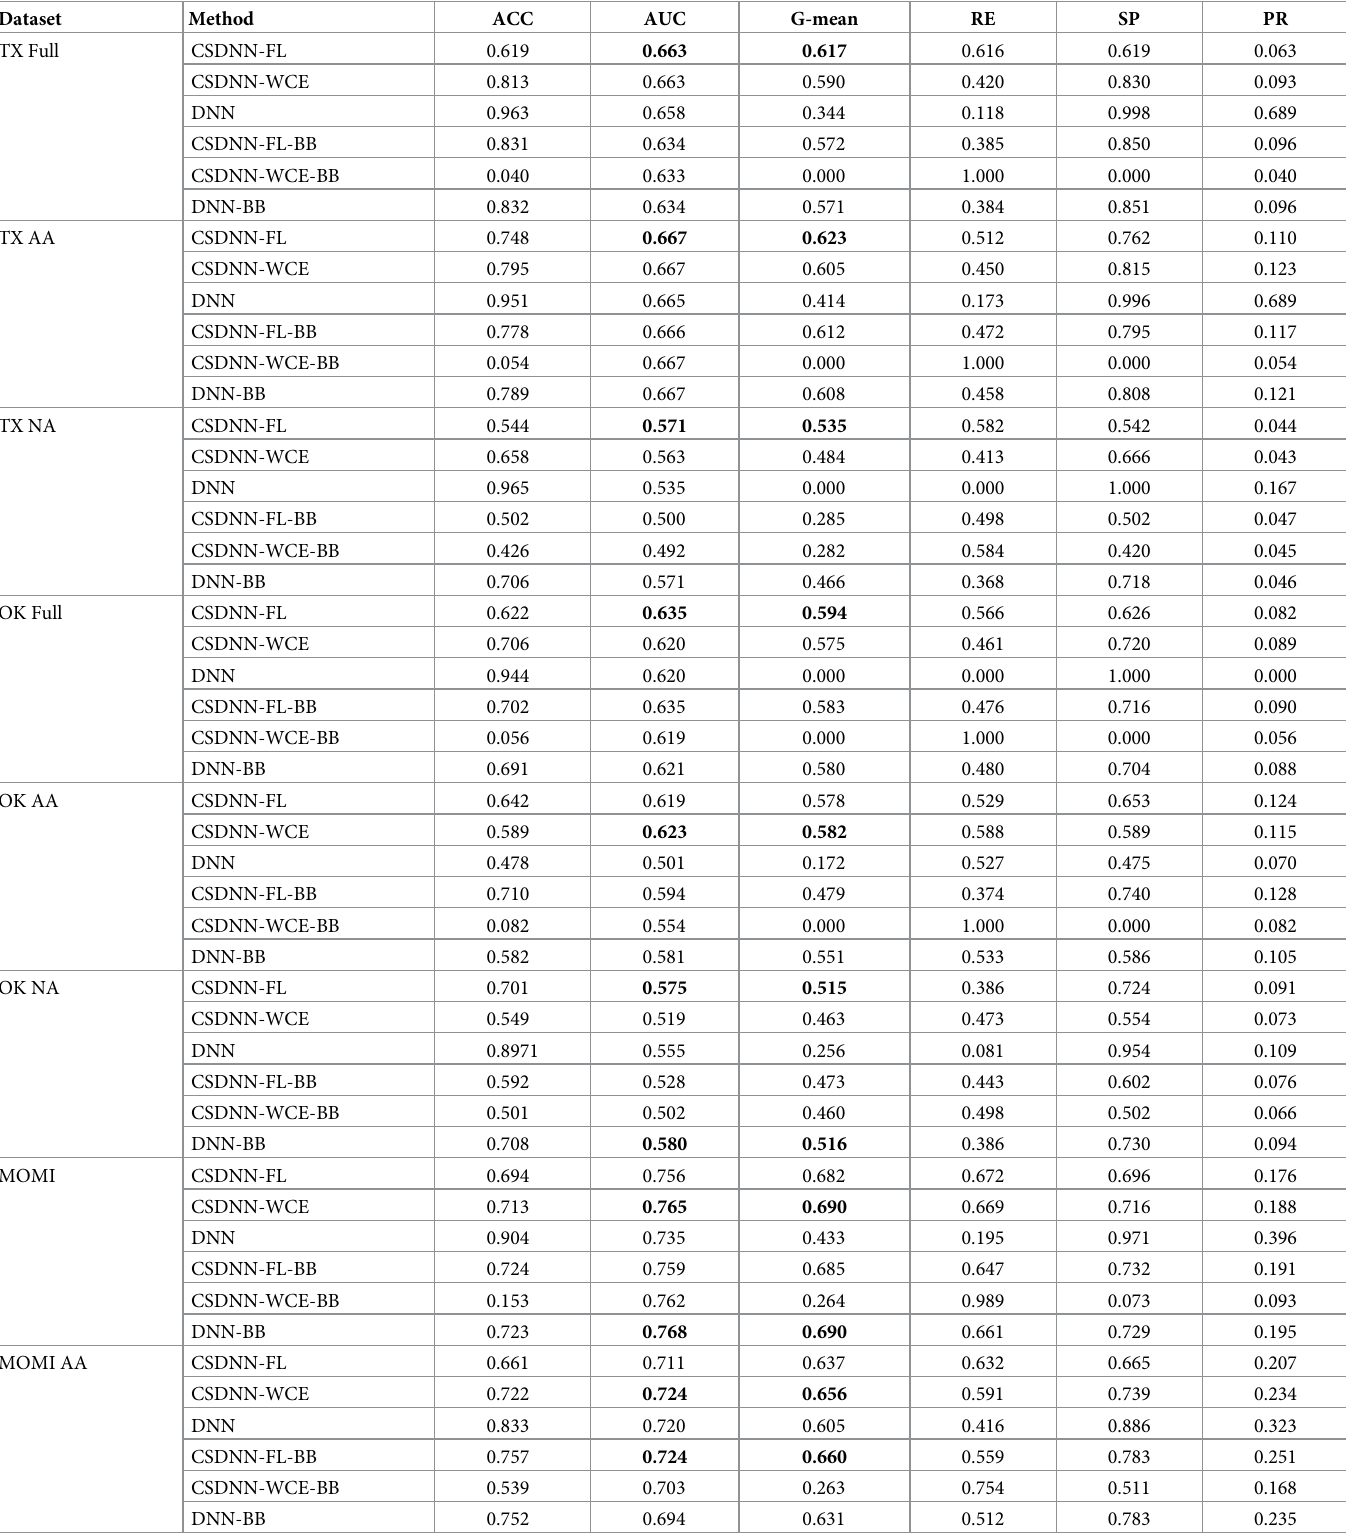
Table 14. Comparison of CSDNN-FL and CSDNN-WCE versus DNN with and without Balanced Batches (BB) on the Full Texas, Oklahoma, and MOMI datasets as well as sub-population datasets. ACC, SP, PR, and RE represents accuracy, specificity, precision, and recall, respectively. The highest G-mean and AUC values are denoted in